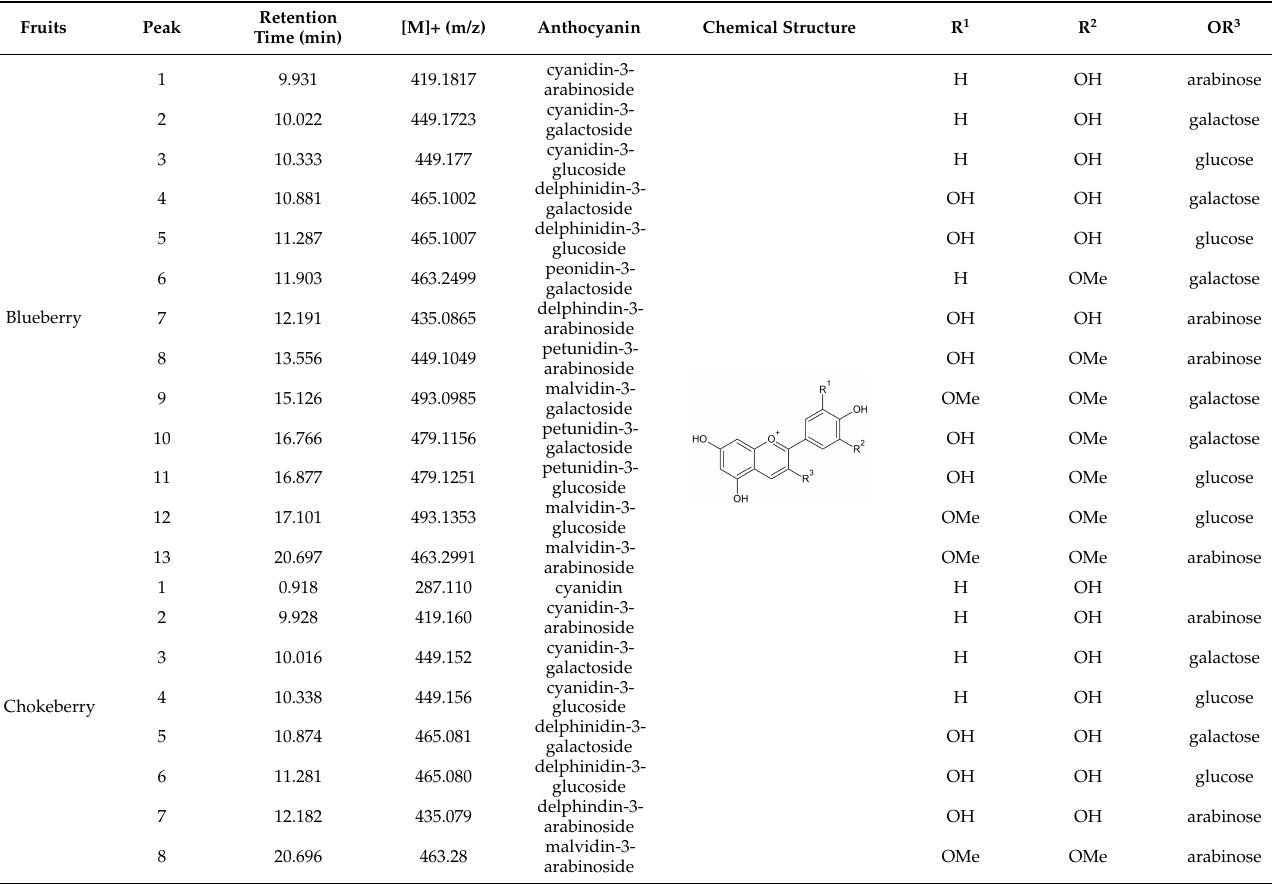
Figure 1. Anthocyanin pigment ( a ) and malvidin-3-galactoside ( b ) concentrations of blueberry extracts obtained using subcritical-water extraction (SWE) as analyzed by the pH differential method and high-performance liquid chromatography (HPLC) analysis. Means in bars with same letters are not significantly different according to Duncan’s test at p < 0.05. Data are mean and SD values ( n = 3). FW (fresh weight) Table 1. Identification of anthocyanins detected by high-performance liquid chromatography-mass spectrometry in blueberry, and chokeberry